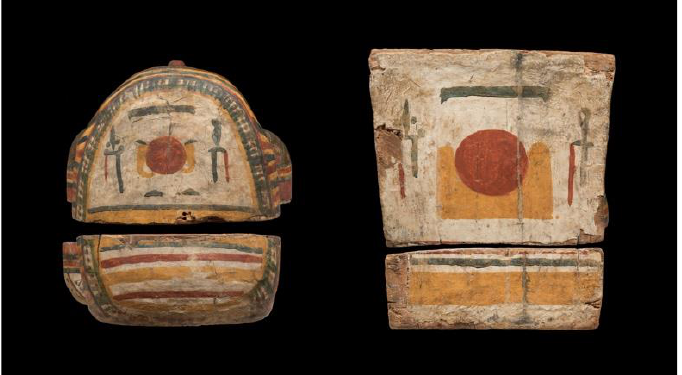
Figure 2. Head end/wall and foot board of Un- Montu’s coffin.